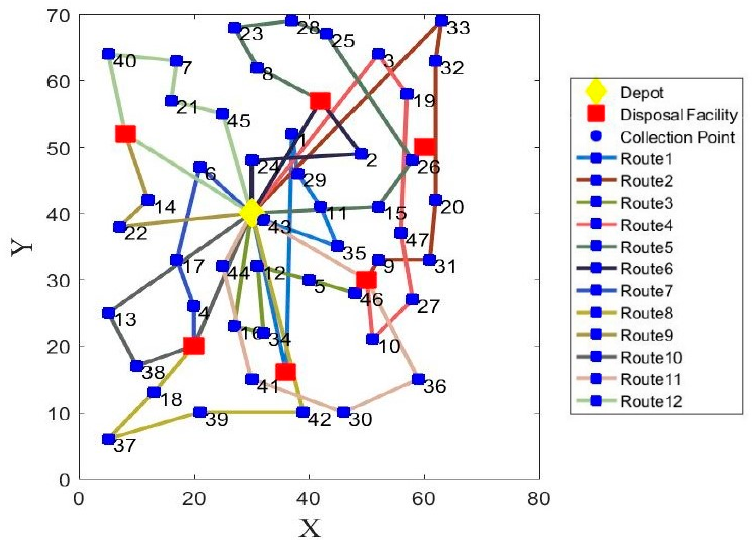
Figure 3. The optimal vehicle routes with minimized operational costs and carbon emissions on Monday (model 1).